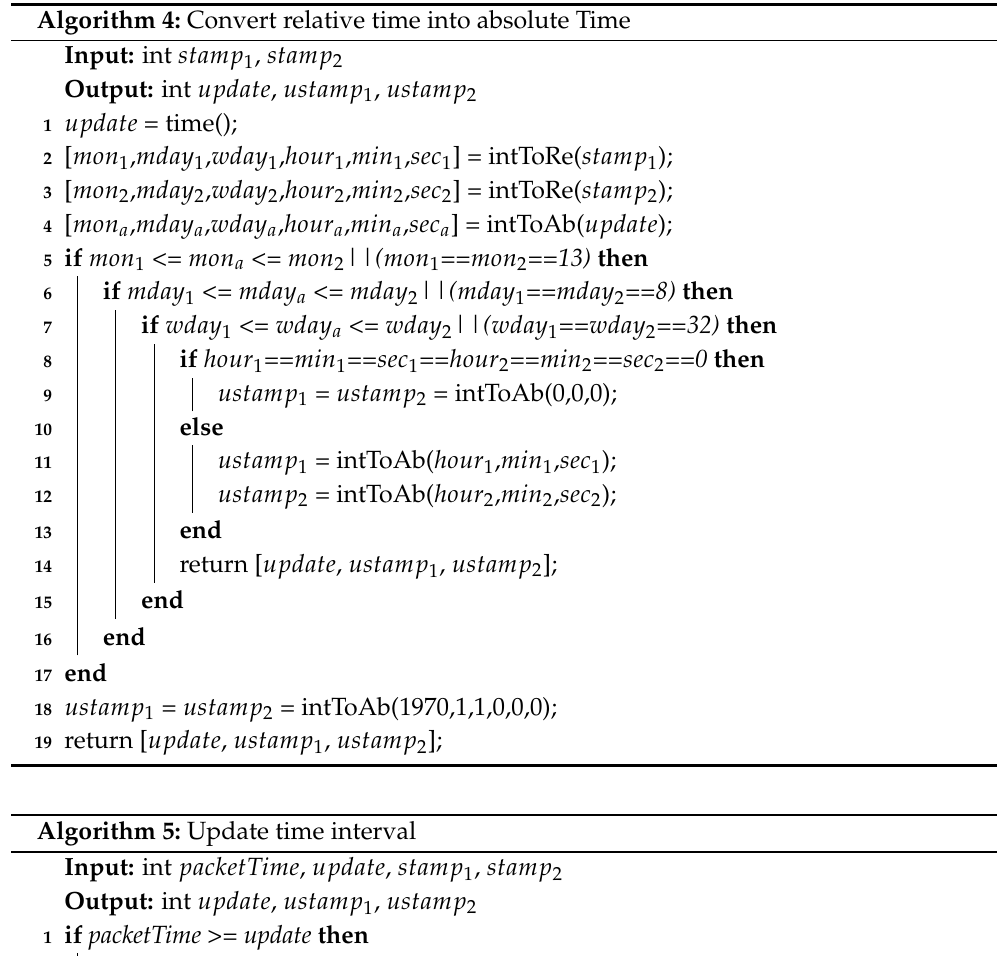
Algorithm 4: Convert relative time into absolute Time